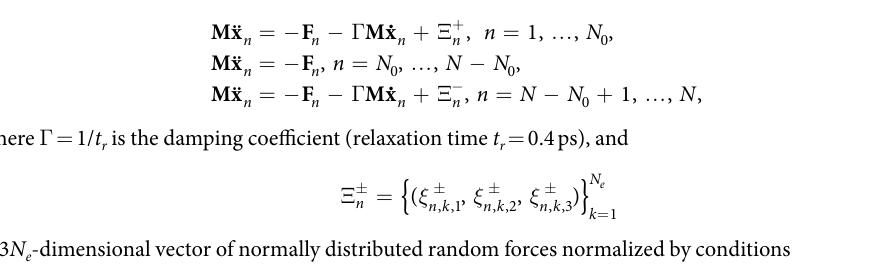
We select the initial conditions for system [Eq. (16)] corresponding to the ground state of the nanoribbon, and solve the equations of motion numerically tracing the transition to the regime with a stationary heat flux. At the inner part of the nanoribbon N 0 < n ≤ N − N 0 , we observe the formation of a temperature gradient corresponding to a constant flux. Distribution of the average values of temperature and heat flux along the nanoribbon can be found in the form